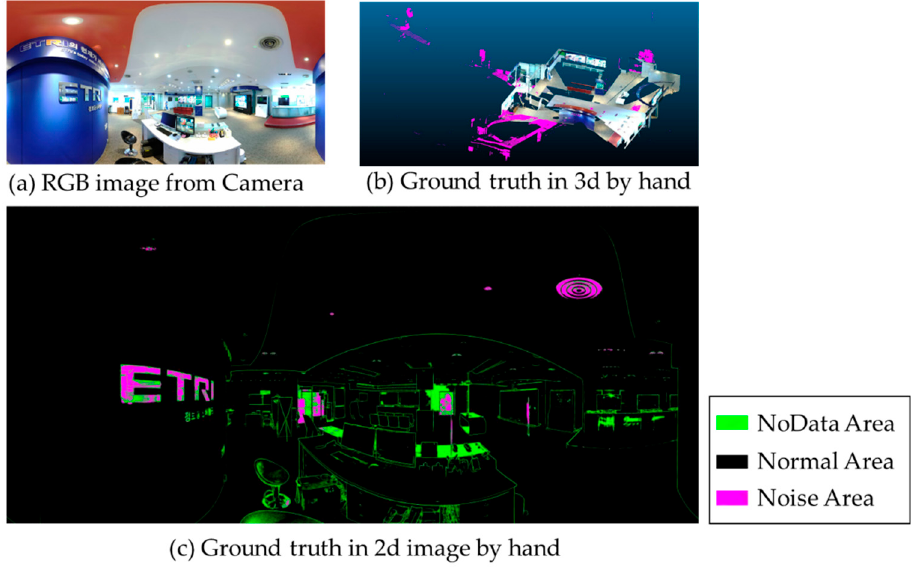
Figure 12. Overview of the ground truth. Table 2. FARO SCENE filter parameters.